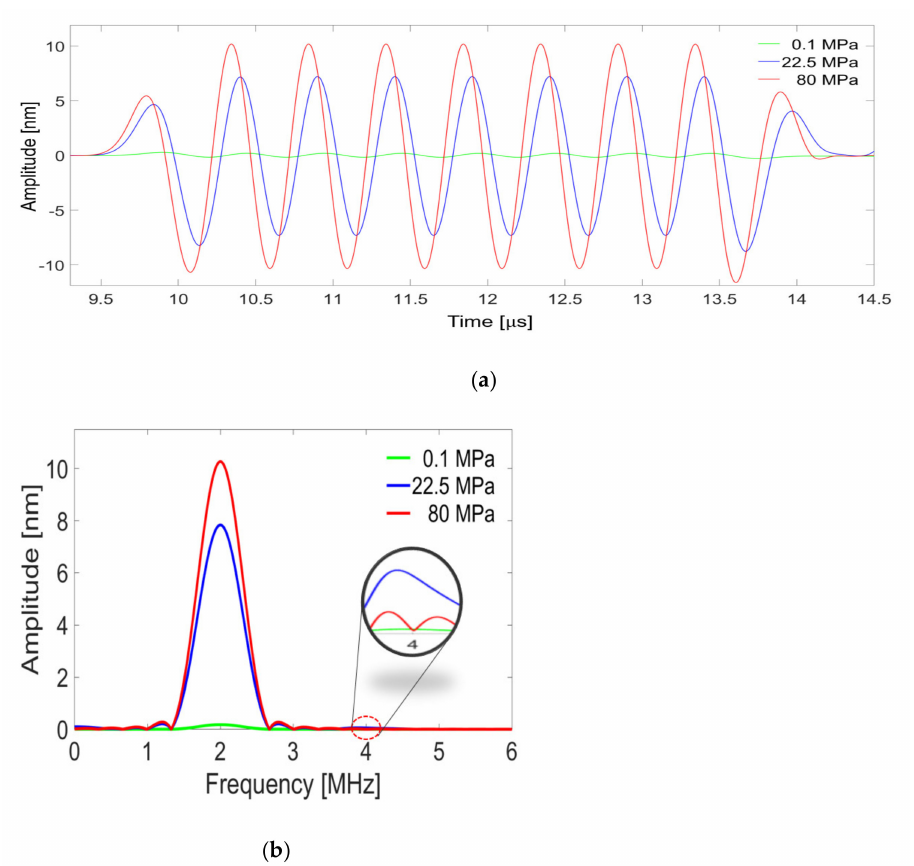
Figure 4. Results of FEM simulation for specimen 2 (C = 4.09 × 10 − 5 [MPa 1 − m · nm − 1 ] , m = 2.601):